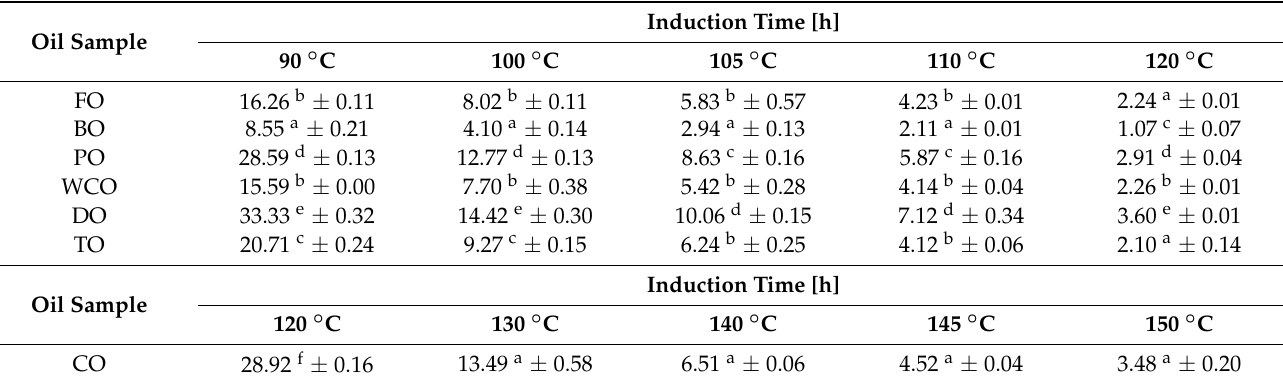
Table 4. Induction time of analysed oils at 90–150 ◦ C determined using the Rancimat